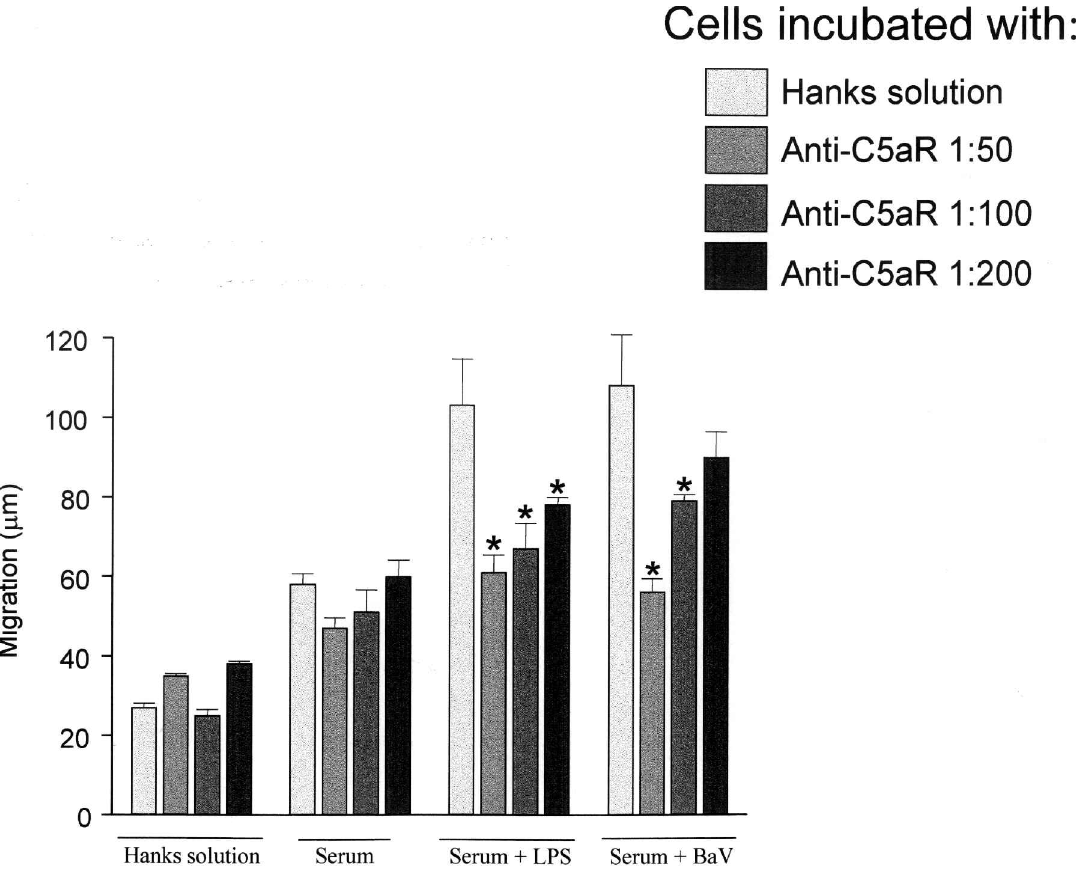
FIG. 3. Chemotactic responses of neutrophils incubated with different concentrations of anti-rat C5a receptor antibody before testing with Bothrops asper venom (BaV)-treated and lipopolysaccharide (LPS)-treated serum. Neutrophils were incubated with the antibody at 37°C for 15min, placed in the top compartment of the chamber and allowed to migrate for 1h. BaV and LPS were incubated with serum for 30min at 37°C, diluted in Hanks’ balanced solution (HBSS) and used as chemotactic agents. Values are mean ± standard error of the mean (SEM) of three experiments each performed in duplicate. * p < 0.01 versus values obtained with incubated serum with HBSS in each